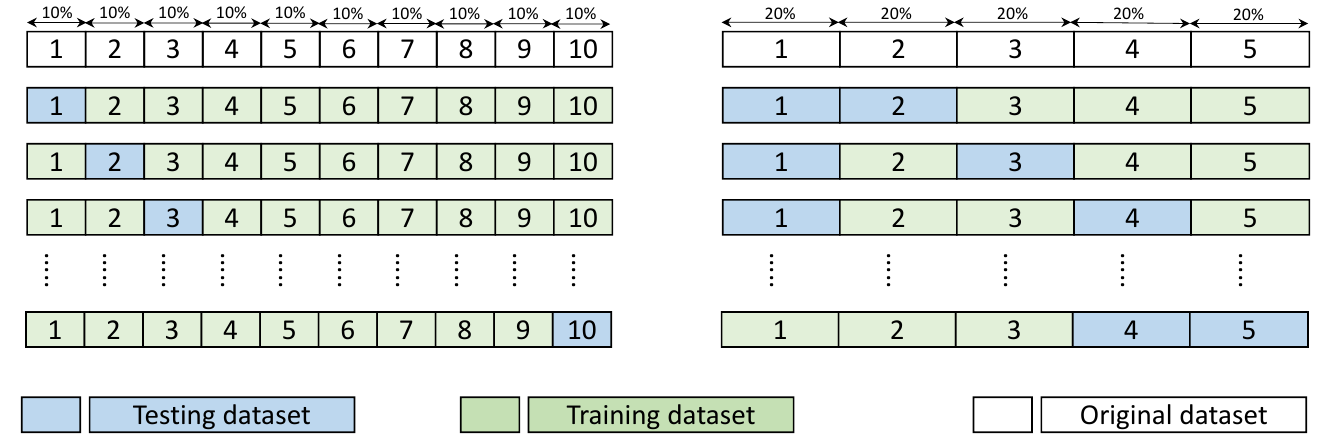
Figure 9. High level abstract for how the datasets are divided in the two k-fold cross-validation schemes.